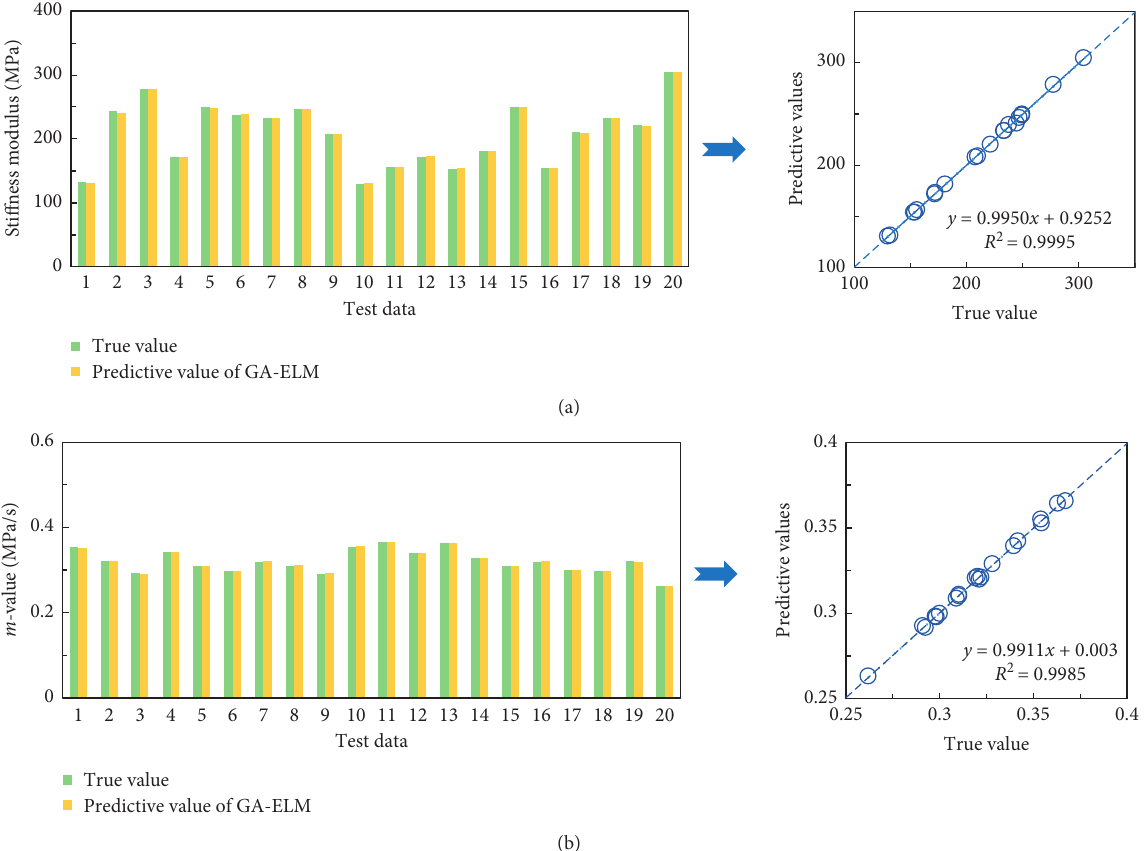
Figure 4: Accuracy of the GA-ELM prediction model. (a) Stiffness modulus. (b) m -value.